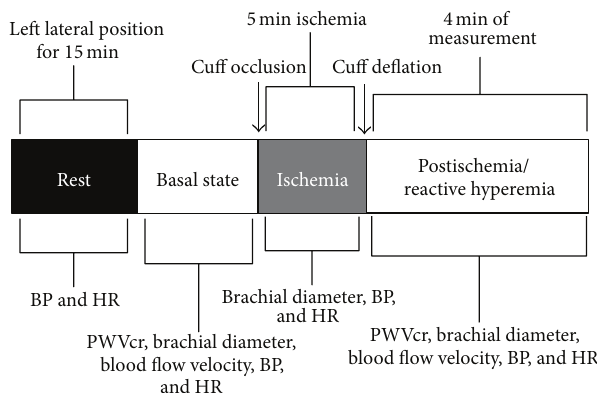
Figure 2: Representative diagram of the study protocol applied to evaluate changes in arterial parameters. PWVcr: carotid-to-radial pulse wave velocity; BP: blood pressure; HR: heart